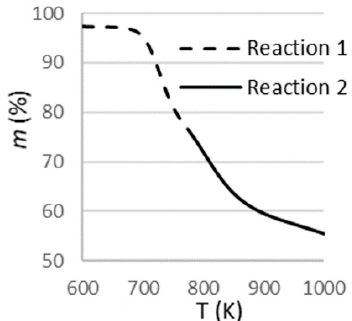
Figure 4. Reactions in the NOMEX mass defined by the second derivative method.